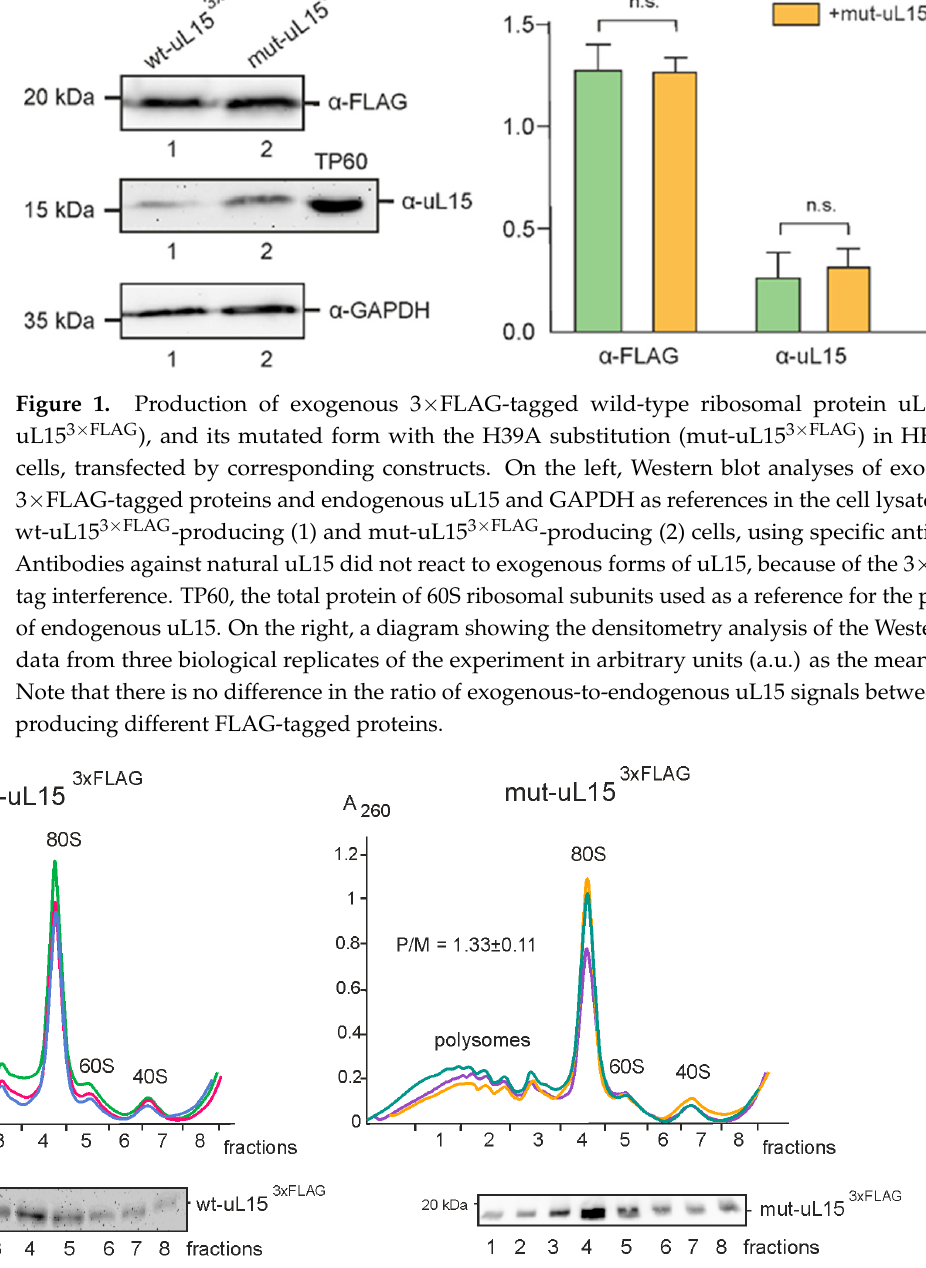
in the profiles with the wild-type protein, indicating inefficient translation in cells where Figure 1. Production of exogenous 3 × FLAG-tagged wild-type ribosomal protein uL15 (wt- mut-uL15 3 × FLAG replaces endogenous uL15 in ribosomes. This is consistent with the early uL15 3 × FLAG ), and its mutated form with the H39A substitution (mut-uL15 3 × FLAG ) in HEK293T cells, transfected by corresponding constructs. On the left, Western blot analyses of exogenous 3 × FLAG- tagged proteins and endogenous uL15 and GAPDH as references in the cell lysates from wt- uL15 3 × FLAG -producing (1) and mut-uL15 3 × FLAG -producing (2) cells, using specific antibodies. Anti- bodies against natural uL15 did not react to exogenous forms of uL15, because of the 3 × FLAG-tag interference. TP60, the total protein of 60S ribosomal subunits used as a reference for the position of endogenous uL15. On the right, a diagram showing the densitometry analysis of the Western blot data from three biological replicates of the experiment in arbitrary units (a.u.) as the mean±SEM. Note that there is no difference in the ratio of exogenous-to-endogenous uL15 signals between cells producing different FLAG-tagged proteins.